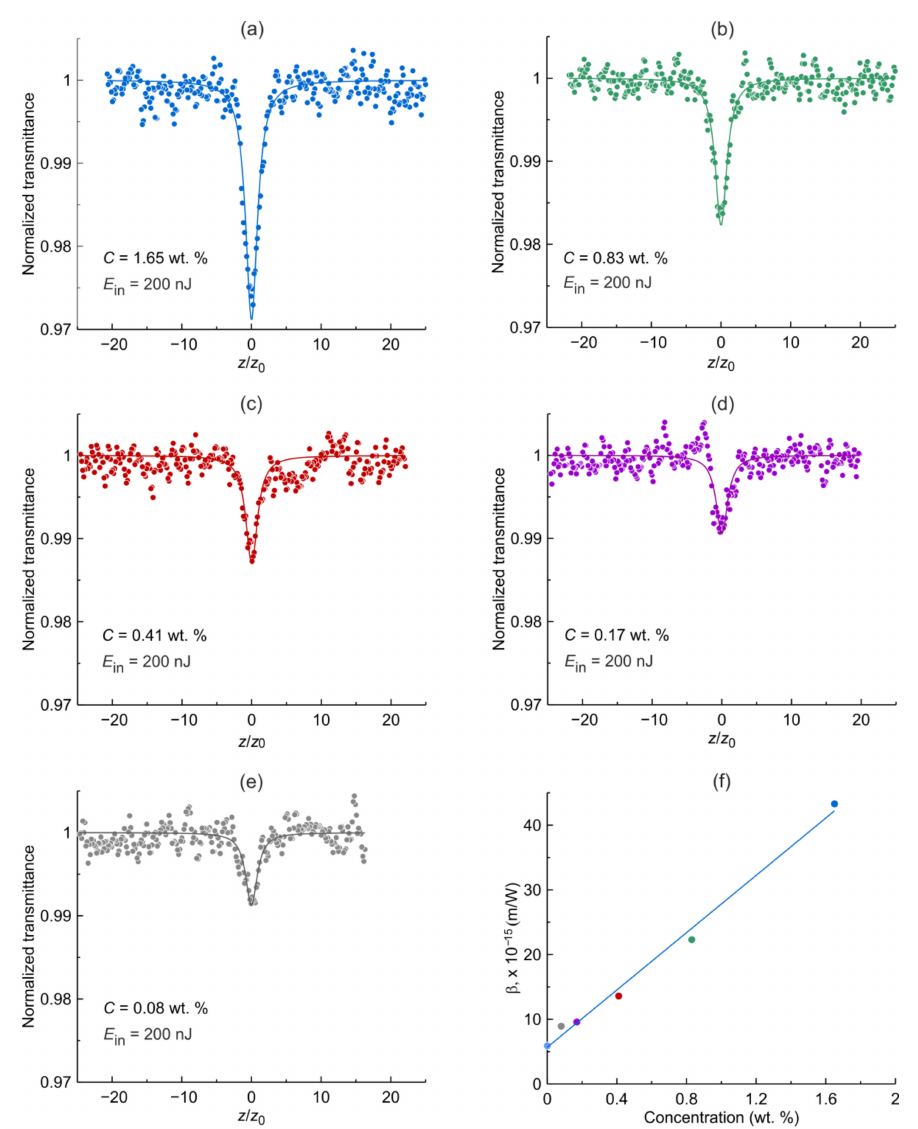
Figure 6. ( a – e ) Normalized transmittance of suspensions of HP-HT nanodiamonds with different concentrations recorded in the open-aperture z-scan. Dots correspond to the experimental data while solid lines represent the result of the fitting with Equation (2). Figure ( f ) represents the dependence of the calculated two-photon absorption coefficient β as a function of concentration